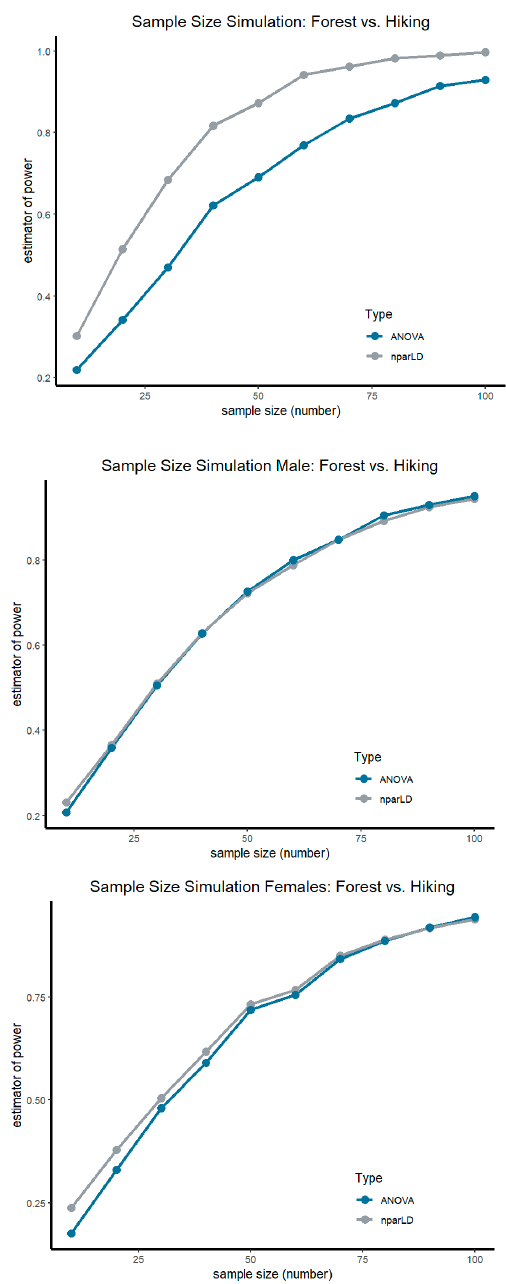
Figure 4. Sample size simulation based on data of the ANKER-Study. Upper graphic shows the comparison of the two intervention groups (forest therapy vs. mountain hiking) for primary outcome SF12 Total Score. The graphs below present gender-specific analyses of aerobic capacity for woman and men. Sample size simulation was performed for nparLD and ANOVA.